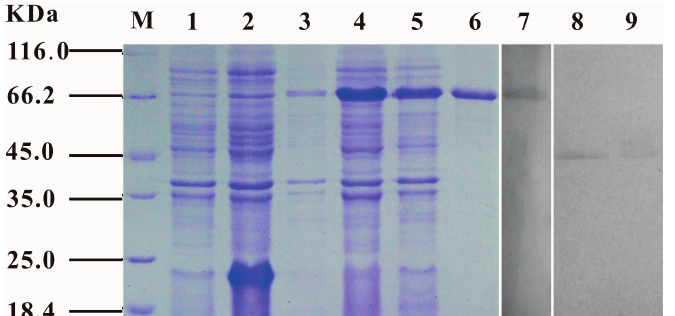
Figure 2. SDS-PAGE and western-blot analysis of S. iniae α -enolase. SDS-PAGE was used to analyze the expression of rENO. Recombinant vectors pET32- eno and pET32a (+) were transformed into E. coli BL21 (DE3) and induced by 0.1 mM IPTG for 4 h at 37 °C. All the samples were analyzed by SDS-PAGE, and the protein was stained with Coomassie Blue R250 in the gel. M, molecular mass marker in KDa; Lane 1–2, the E. coli BL21 (DE3) including pET32a (+) was no-induced and induced, respectively; Lane 3, the E. coli BL21 (DE3) including pET32- eno was no-induced; Lane 4–5, the supernatant and precipitation of the E. coli BL21 (DE3) including pET32- eno was induced; Lane 6, purified rENO protein. Western-blot was used to analyze the localization of S. iniae α -enolase. The rabbit anti-rENO antibodie (1:100) was used to probe the cell wall and cytoplasmic protein fraction of S. iniae , and purified rENO was used as control; Lane 7, purified rENO; Lane 8, cell wall protein fraction; Lane 9, cytoplasmic protein